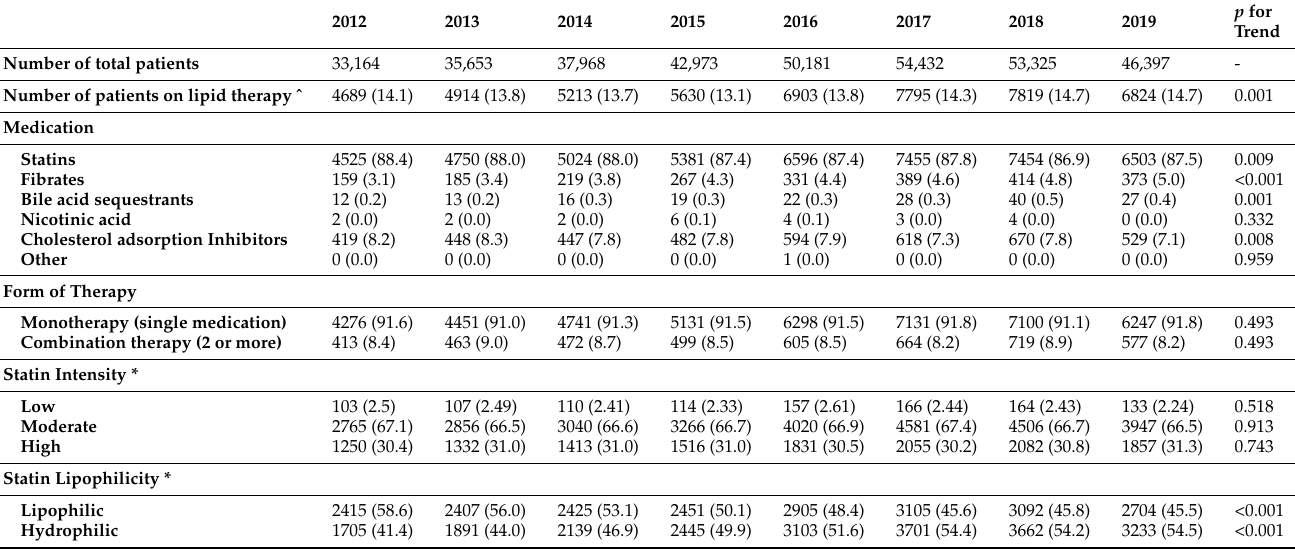
Table A3. Prescription patterns of lipid-lowering medications in the ePBRN cohort by year.